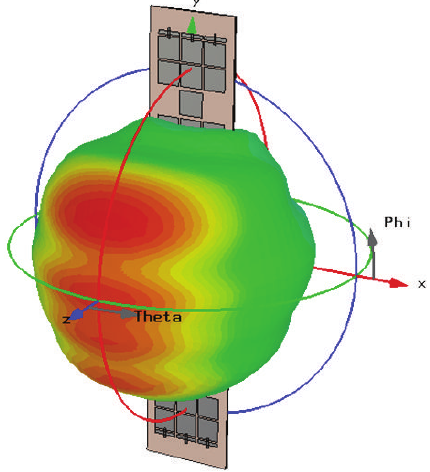
Figure 11: Radiation pattern for complete antenna/EBG with PIN diodes short circuit, normal